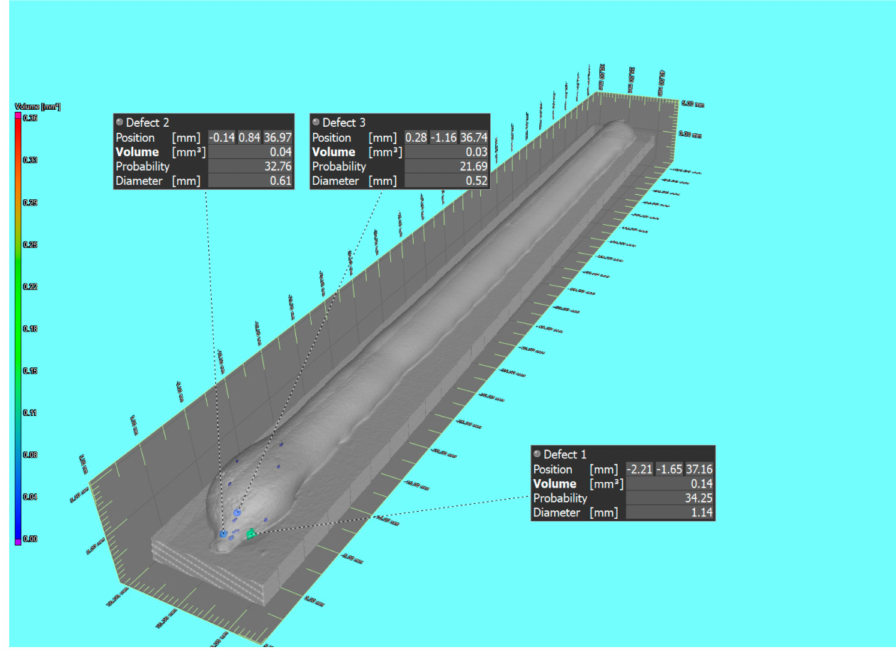
Figure 2. Perspective space view of the pores in weld with 15 ◦ obliquity of the welding gun.